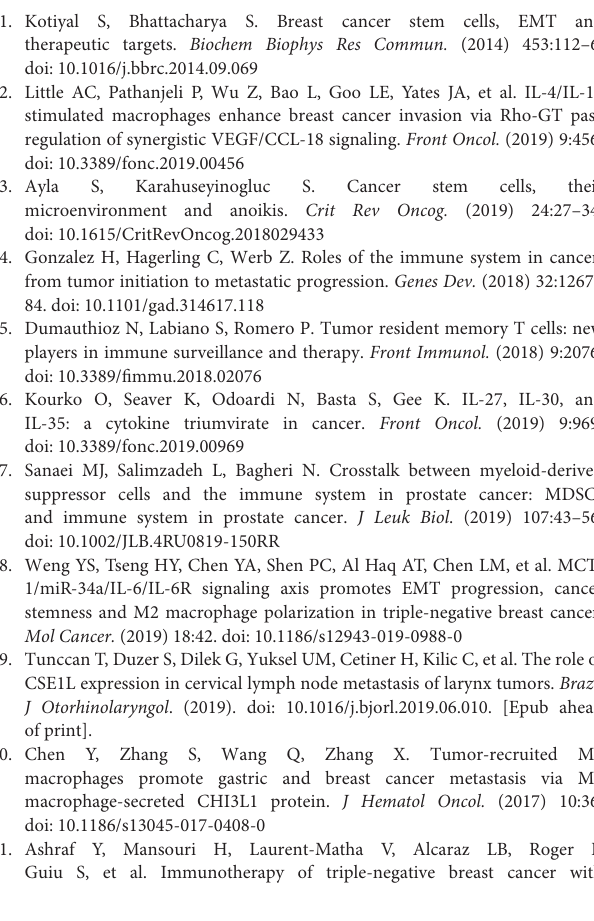
Supplementary Table 1 | Up- and downregulated proteins in co-cultured PBMC proteome relative to PBMC control, and up- and downregulated proteins in